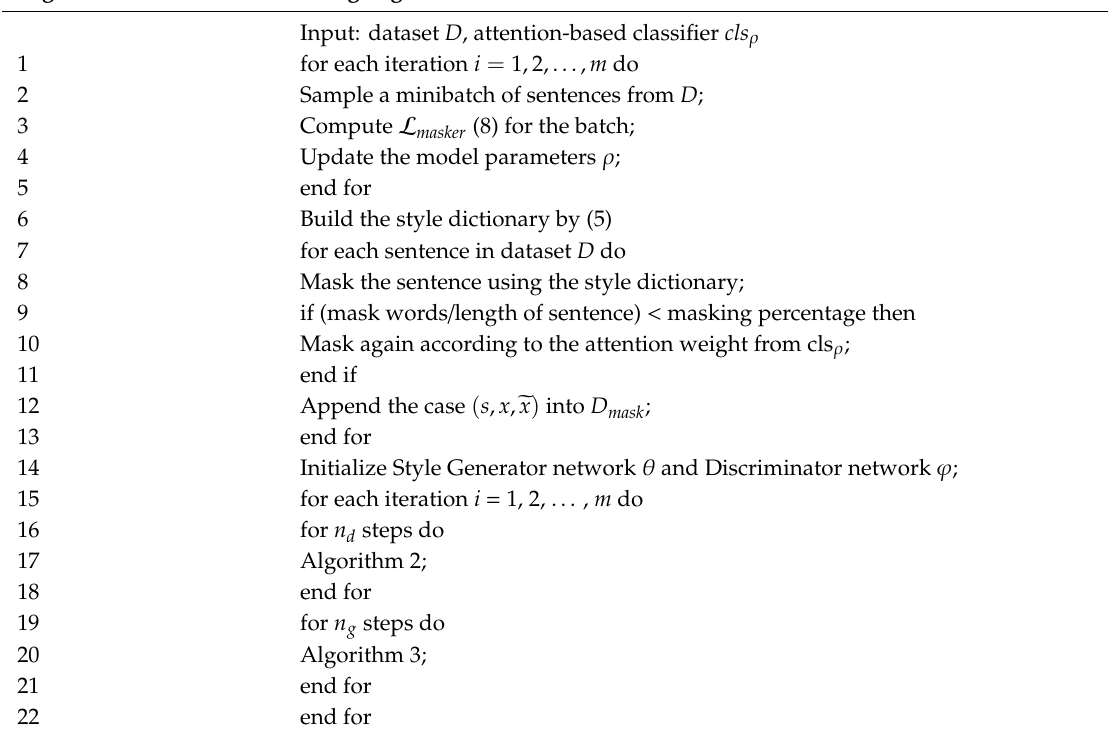
Algorithm 3: The Whole Training Algorithm